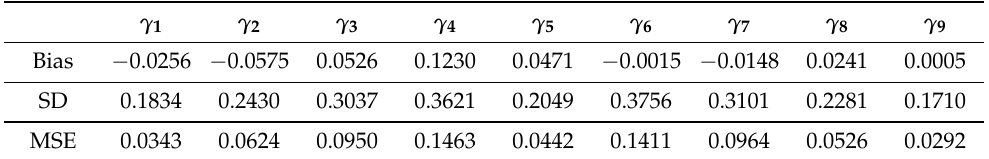
Table 2. Bias, SD and MSE evolutions with respect to the parameter γ variation for PLGSIMF with the identity link function and n = 500.